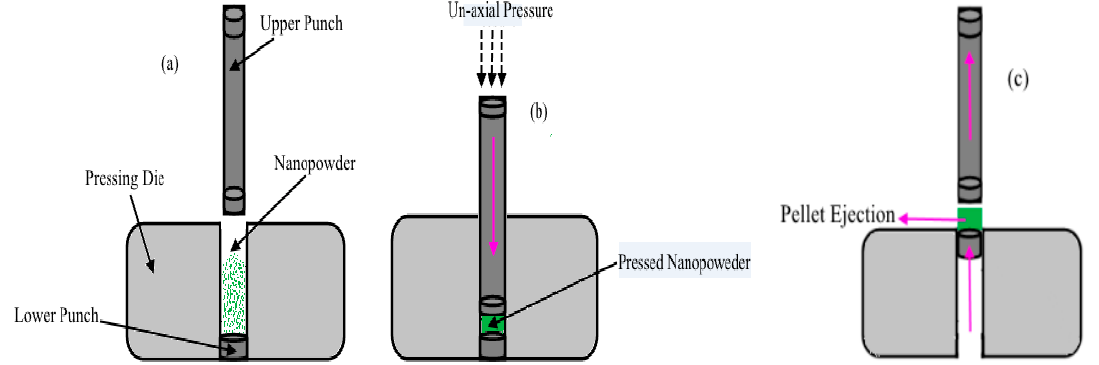
Figure 2. Samples fabrication process: ( a ) Die filling stage. ( b ) Pressed nanopowder. ( c ) Pellet ejection.